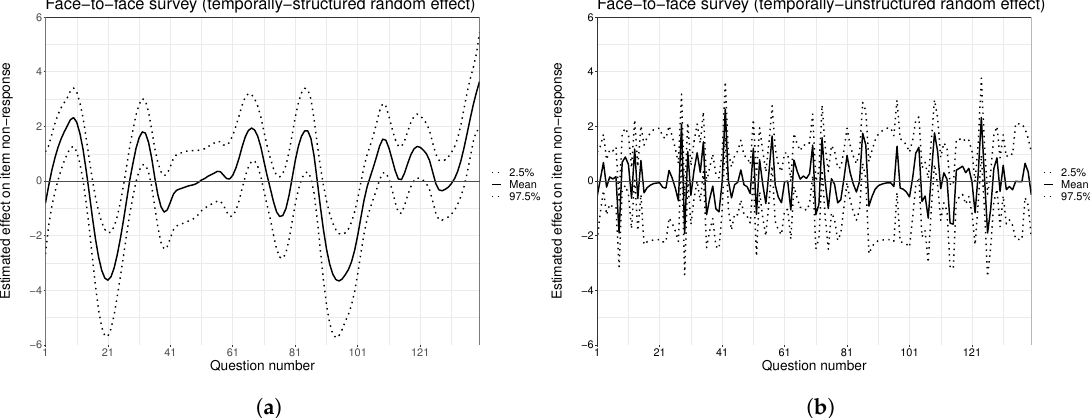
Figure 3. Estimation of the structured ( a ) and unstructured ( b ) temporal random effects considered for modeling item non-response values in the face-to-face survey. These estimates correspond to ˆ γ j ( a ) and ˆ φ j ( b ) according to Equation